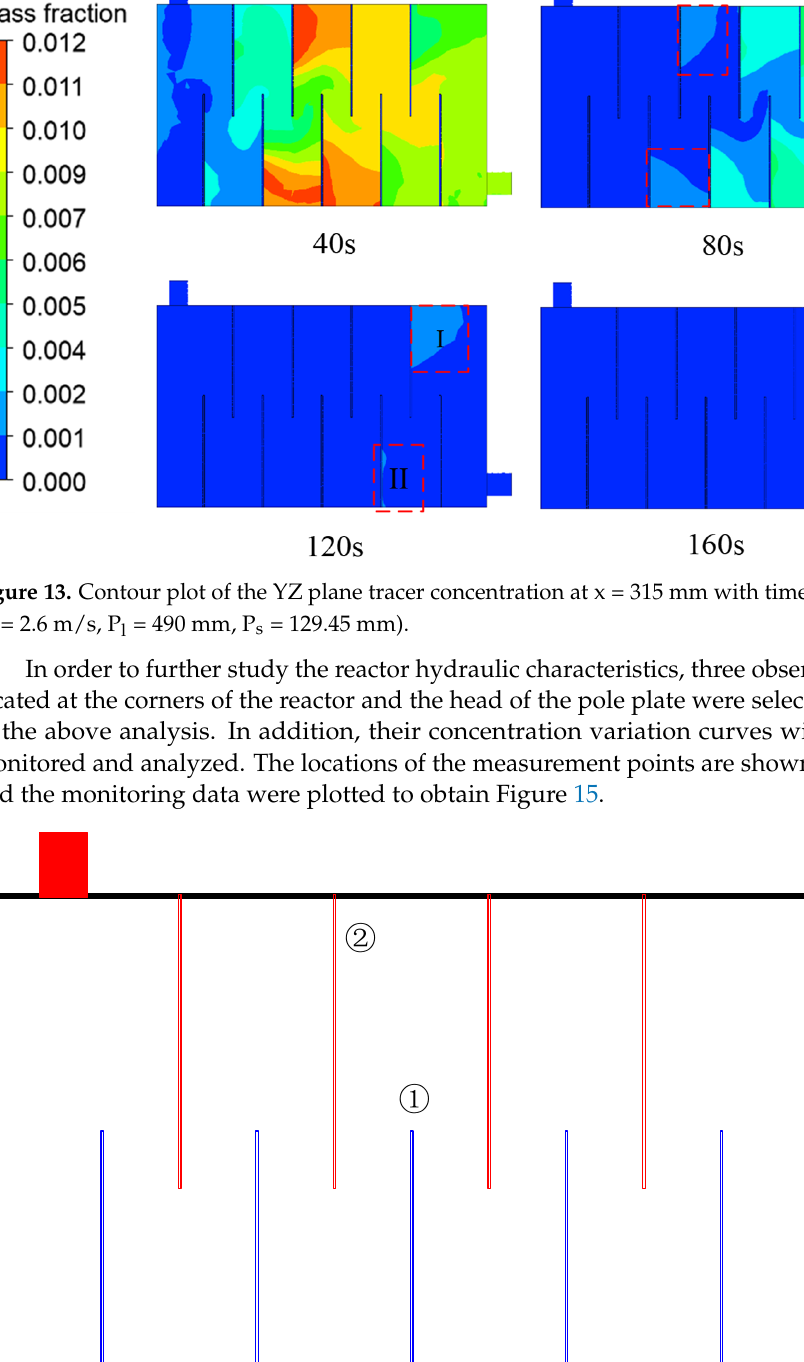
Figure 14. Schematic diagram of the position of each measurement point in the reactor.